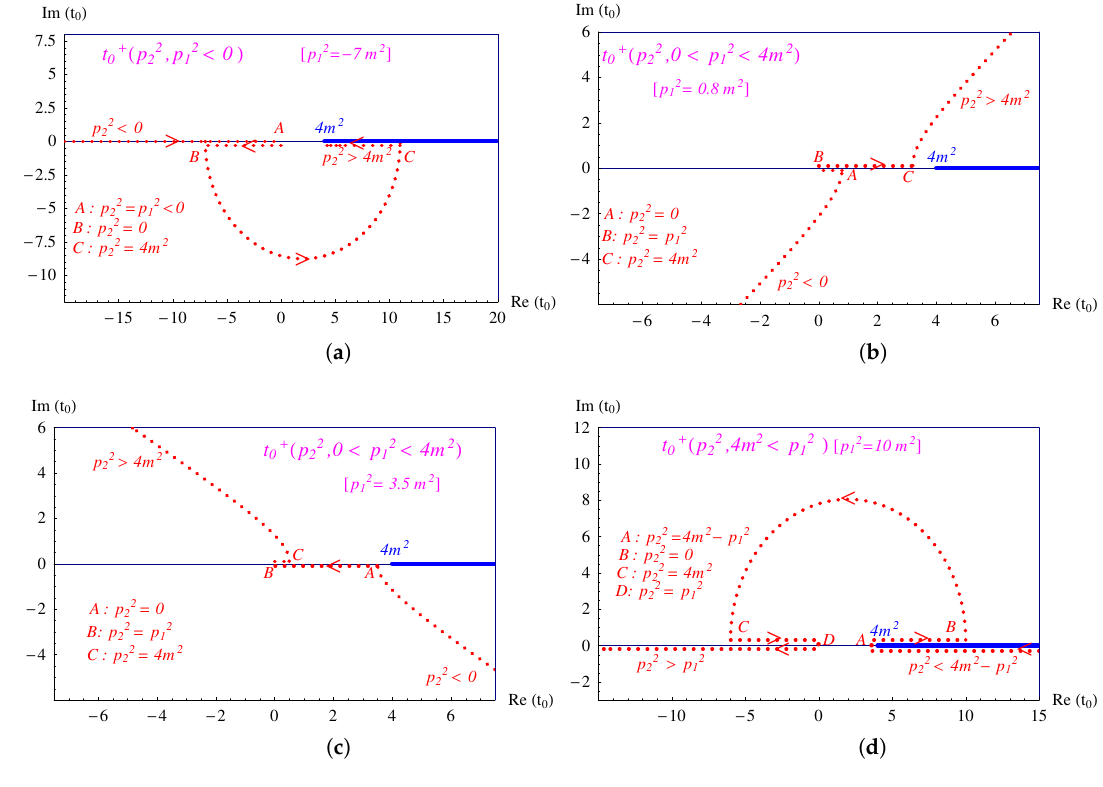
( p 2 ) vs. p 2 , p 2 at a fixed value of p 2 2 2 1 0 = 3.5 m 2 ; ( d ) 4 m 2 < p 2 = 10 m 2 ]. The normal cut [ p 2 1 1 1